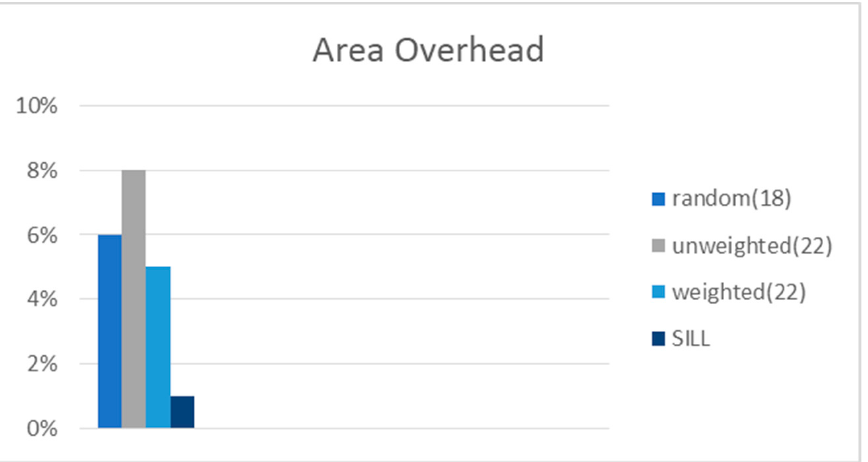
Figure 12. Comparing the Hamming distance of the proposed method (SILL) with other methods.